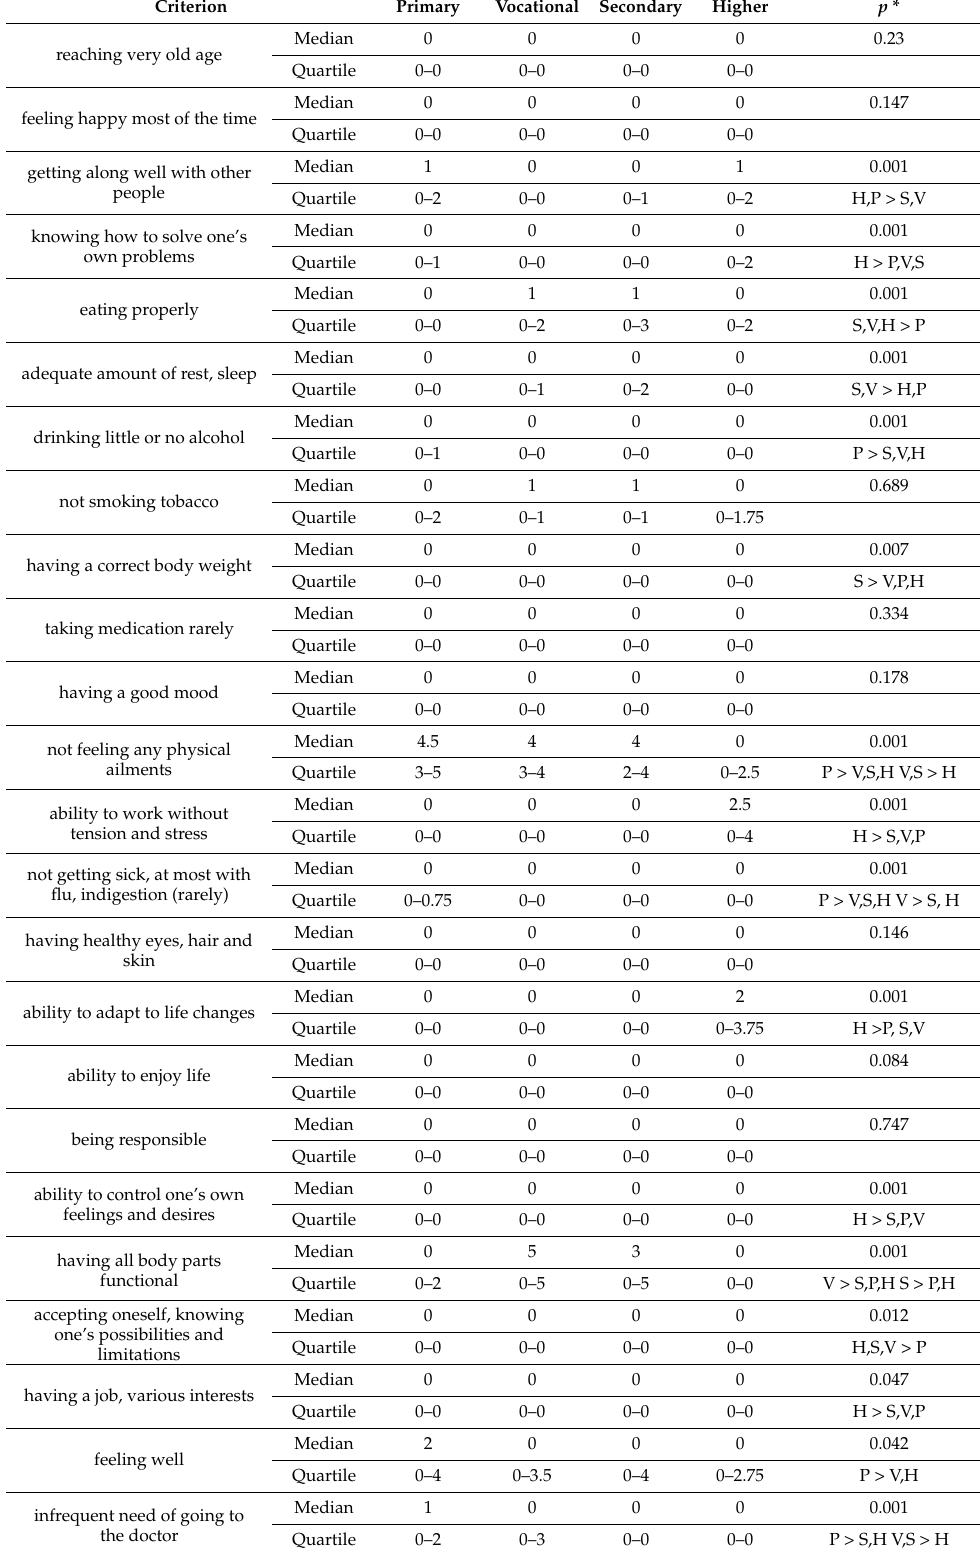
Table 7. Correlations of health statements with the education of the